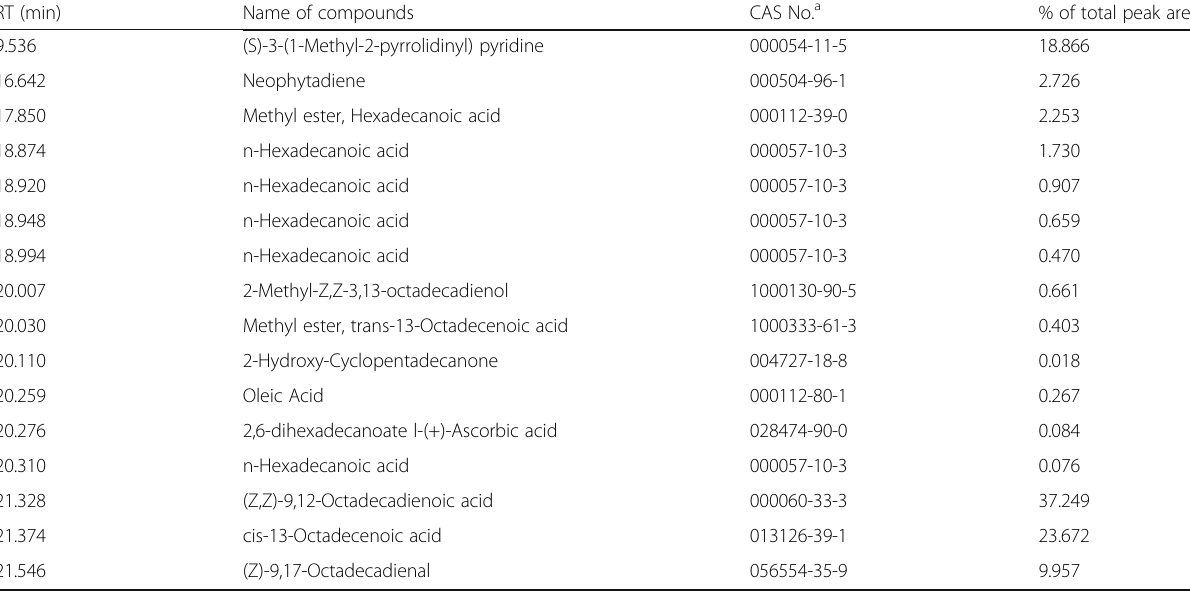
Table 4 Compounds identified in mixture of Nicotiana tabacum plus Jatropha curcas